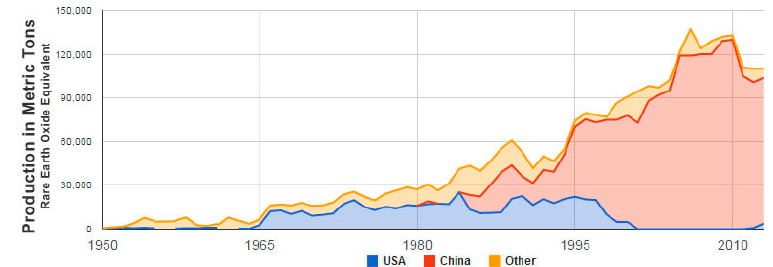
Figure 1. Production of REE oxides from 1950 in USA, China, and other countries.